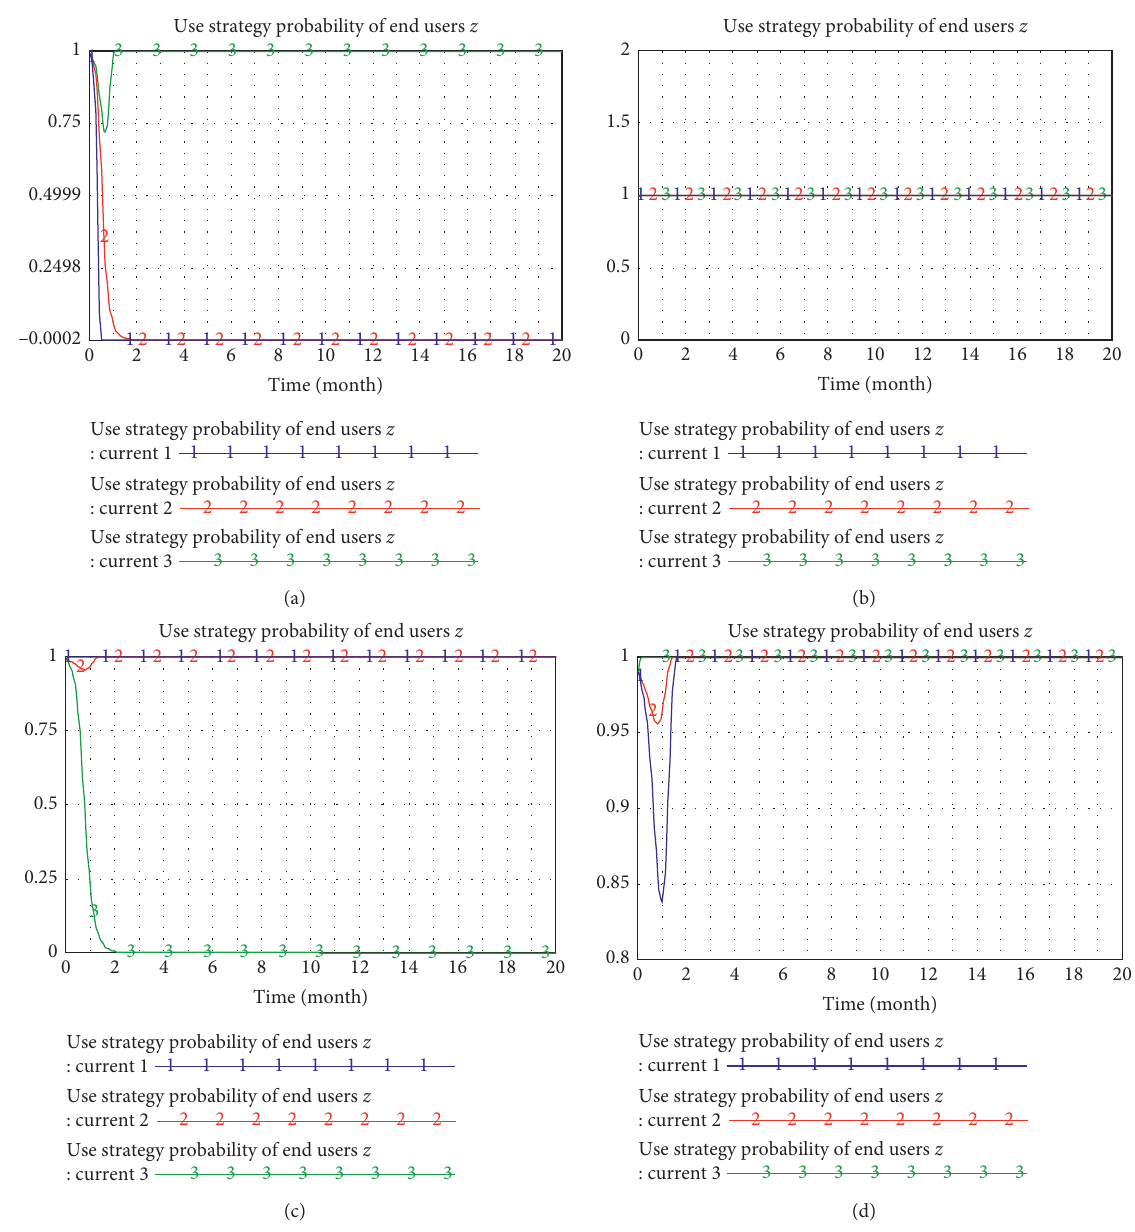
Figure 14: The impact of external variables on the end user’s strategy choice: (a) Current 1: I (b) Current 1 : C 5 � 8, Current 2: C 5 � 10, and Current 3: C 5 � 12; (c) Current 1 P 3 � 10, Current 2 : P 3 � 14, and Current 3 : P 3 � 18; (d) Current 1: c � 0.1, Current 2 : c � 0.4, and Current 3: c �